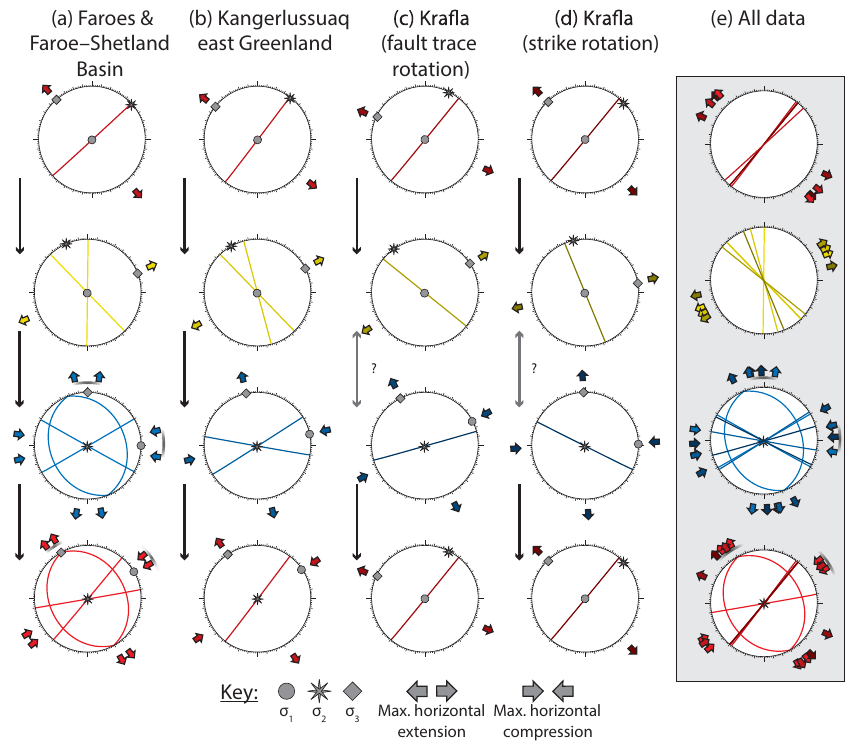
Figure 12. Comparison of averaged structural orientations and kinematics for the Faroe Islands (a) and east Greenland (b) . (c) Krafla data are reflected and rotated so that the surface traces match the NE Atlantic basin system. (d) Krafla data are reflected and rotated so that the measured planar data match the measured data from the NE Atlantic basin system. (e) Combined summary of orientations and kinematics from each study